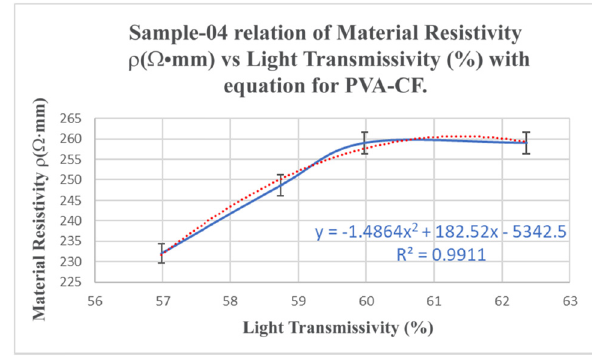
Figure 30: Sample - 05 ( CF:PVA = 1.0:30 ) material resistivity ρ ( Ω mm ) versus light transmittance ( % ) with equation for PVA - CF. The dotted lines represent the polynomial fi tted curve and the linear fi tted.